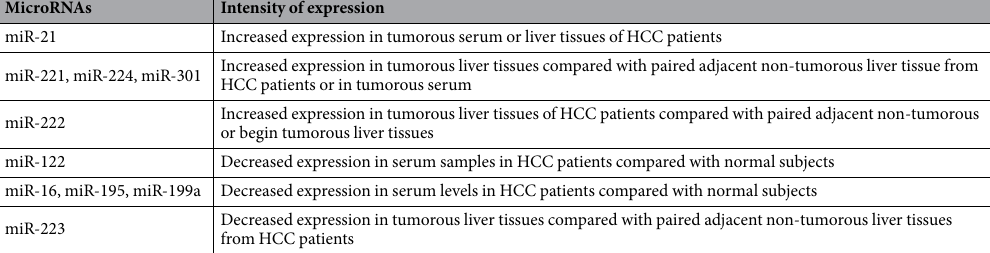
Table 1. List of microRNAs associated with HCC patients.